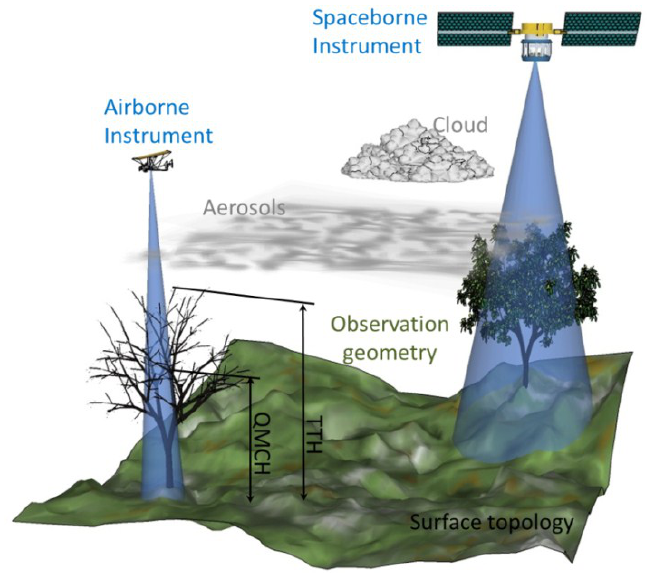
Figure 1. Illustration of airborne and spaceborne lidar